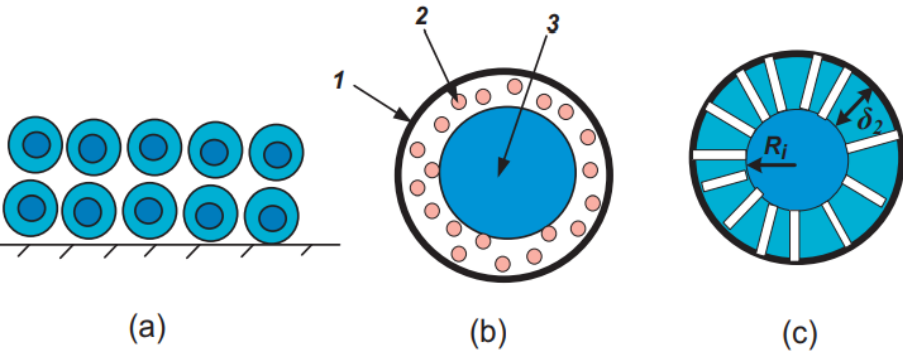
Figure 1. Three-layer model of gas hydrate dissociation assuming a spherical granule configuration. ( a ) Small granules in a thin boundary layer. ( b ) Gas hydrate particle model generally accepted in the literature: (1) an ice crust with a thickness δ 2 ; (2) a thin layer of methane formed during the hydrate decomposition; (3) undecomposed methane hydrate under stable thermodynamic conditions. ( c ) Model proposed in [46].